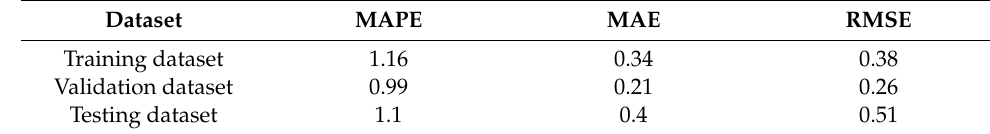
Table 3. Computed errors for training, validation, and testing dataset of the estimation network.